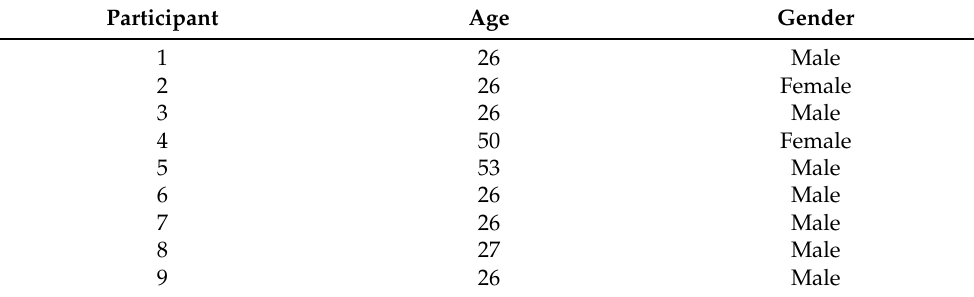
Table 1. Information of participants in the experiments.